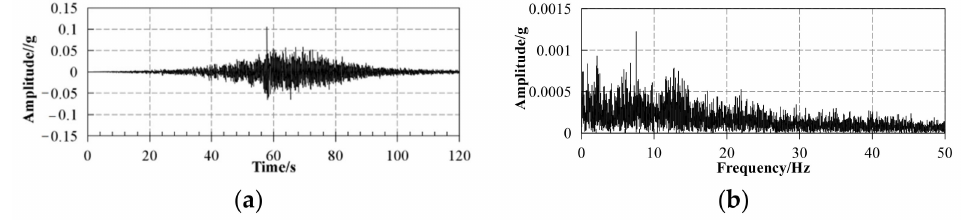
Figure 5. The input WE wave (0.1 g): ( a ) time history, ( b ) Fourier